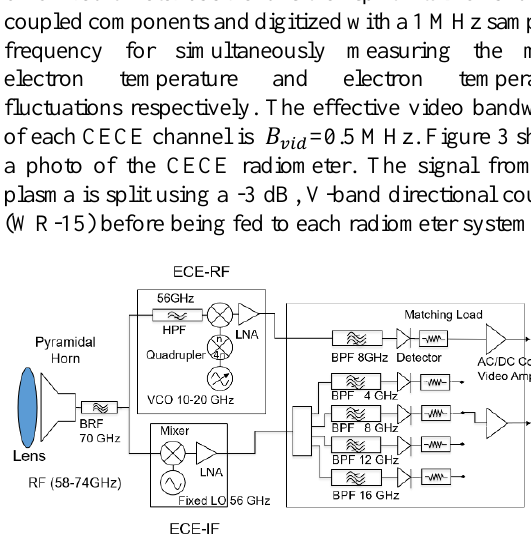
Fig. 2. Schematic view of correlation ECE radiometer in Heliotron J .